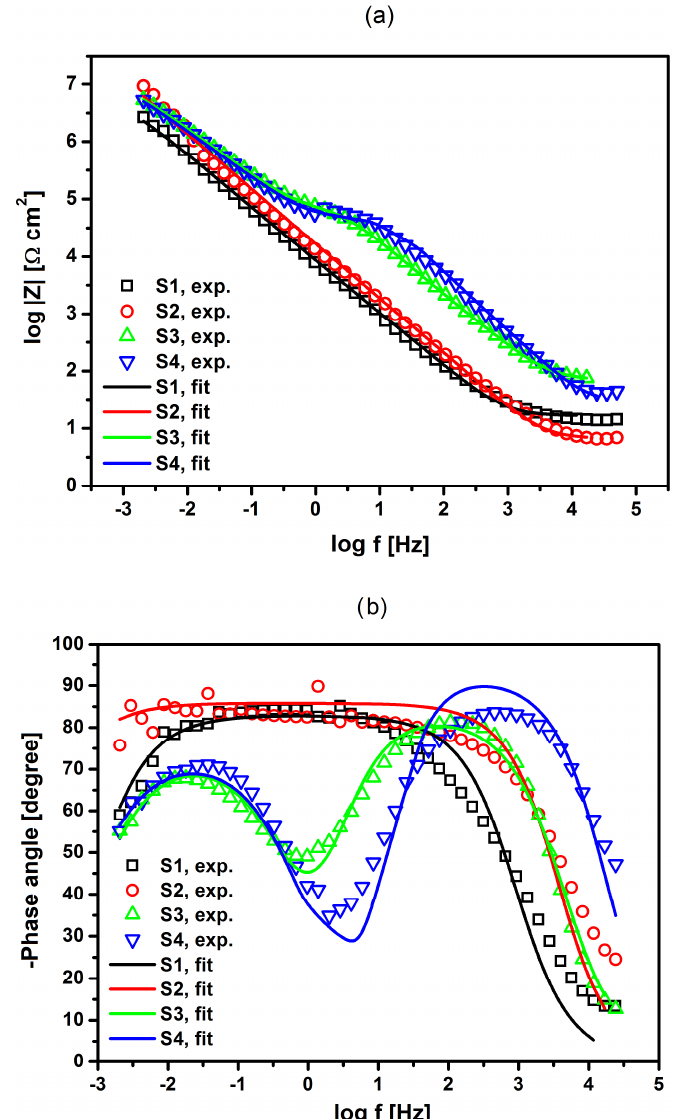
Figure 12. Bode plots log | Z | vs. log f ( a ) and Bode plots ϕ vs. log f ( b ) for the NiTi alloy before and after surface modification in Ringer’s solution at 37 ◦ C. Experimental AC impedance data are represented by symbols; fitting results obtained using CNLS method and models shown in Figure 11 are shown as continuous lines. Legend: S1—NiTi alloy after mechanical polishing, S2—NiTi alloy after passivation in a steam autoclave, S3—NiTi alloy after sterilization with a sintered HAp / nSiO 2 / Ag coating (10:1, 40 V / 90 s) and S4—NiTi alloy after sterilization with sintered HAp / nSiO 2 / Ag coating (5:1, 50 V / 120 s).